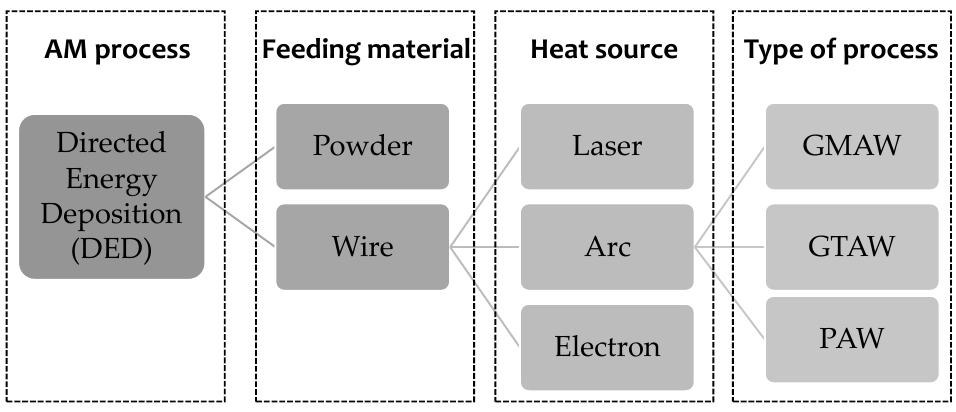
Figure 2. Classification of the DED process [3].